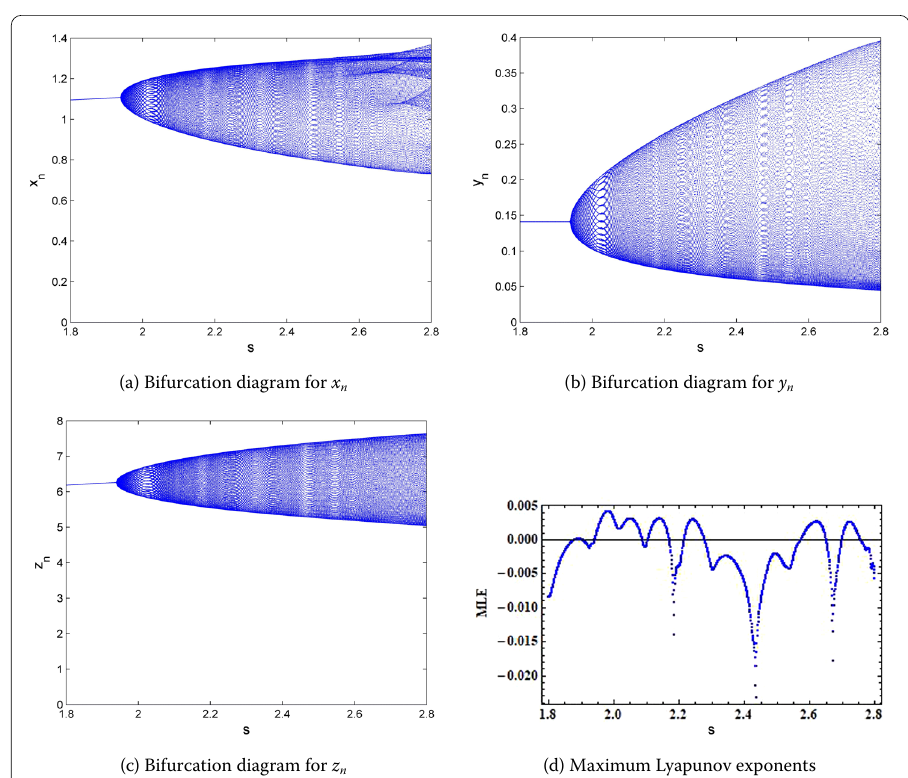
Figure 2 Bifurcation diagrams and MLE for system (1.3) with α = 1.6, k = 1.4, β = 0.13, δ = 0.4, μ = 0.15, γ = 2.95, η = 0.1, c = 0.5, ( x 0 , y 0 , z 0 ) = (1.10514,0.141,6.2505) and s ∈